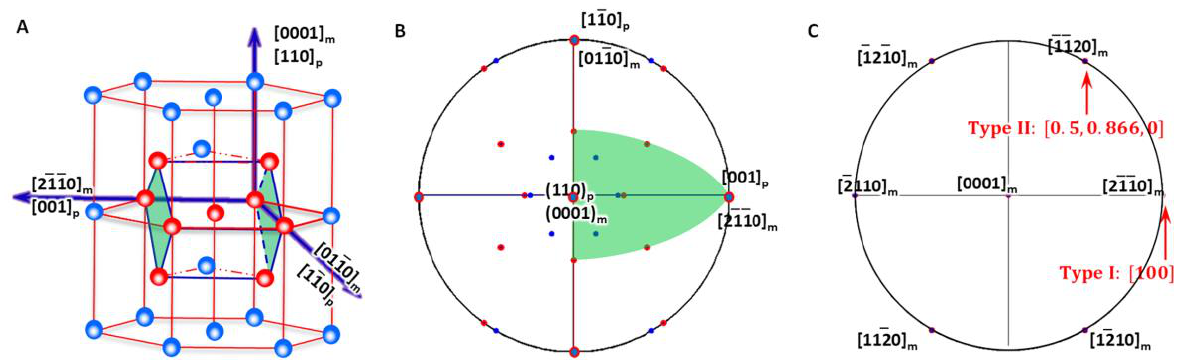
Figure 4. Lattice correspondence between HCP and BCC structures. ( A ) 3D atomic model showing how to obtain a BCC lattice from two HCP unit cells. ( B ) Stereographic projection showing the initial P-S OR corresponding to lattice correspondence. ( C ) Burgers vector and shear plane variants in reference coordination system.